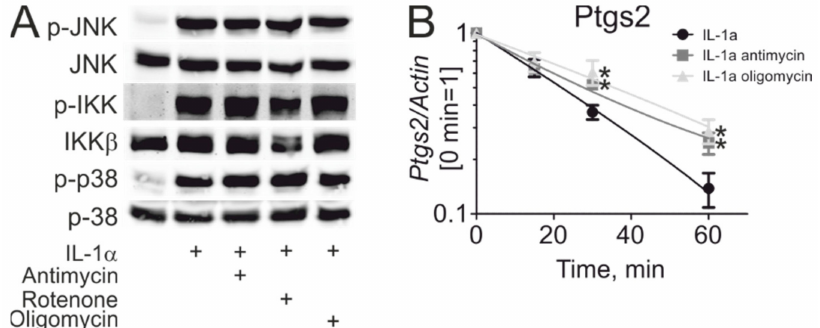
Figure 2. Inhibitors of oxidative phosphorylation increase Ptgs2 mRNA stability. ( A ) Western blot analysis of c-Jun N-terminal kinase (JNK), I κ B kinase (IKK), and p38 mitogen-activated protein kinase (MAPK) phosphorylation in astrocytes treated for 0.5 hours with IL-1 α in the presence or absence of rotenone, oligomycin, and antimycin, as indicated. ( B ) The mRNA expression of Ptgs2 in astrocytes treated with IL-1 α , antimycin, and oligomycin for 1 hour followed by actinomycin D for indicated times. Note: *, p < 0.05 vs. IL-1 α . Data represent mean values ± SE of 3 or 4 independent